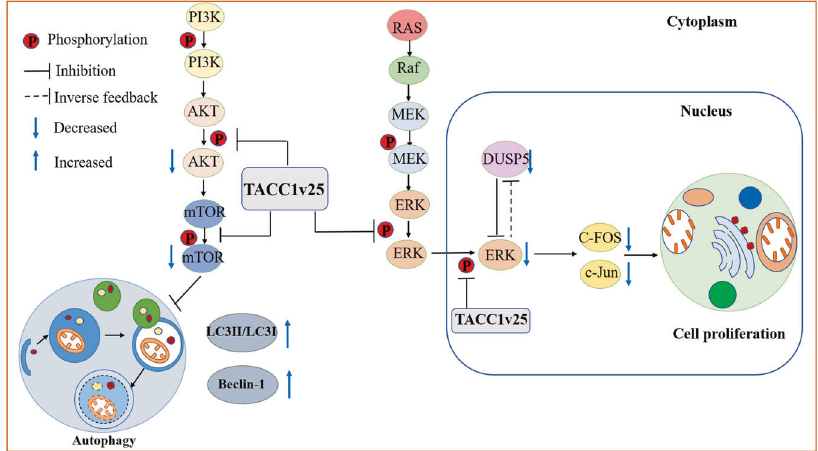
Fig. 8 Schematic of the role of TACC1v25 in HNSCC. Ectopic TACC1v25 inhibits the expression of overall pERK and nucleus pERK. It decreases the expression of downstream genes, such as c-Fos and c-Jun, resulting in cell proliferation inhibition. Meanwhile, the ERK-speci fi c inducible ribozyme, DUSP5, is also downregulated. On the other hand, ectopic TACC1v25 downregulates p-AKT and p-mTOR resulting in an increase in the autophagosome and autophagic protein markers LC3II and Beclin-1 in HNSCC cell